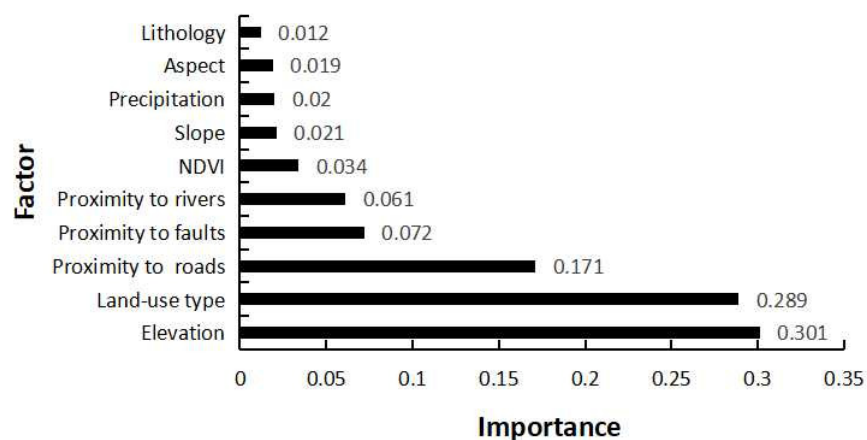
Figure 7. Factor